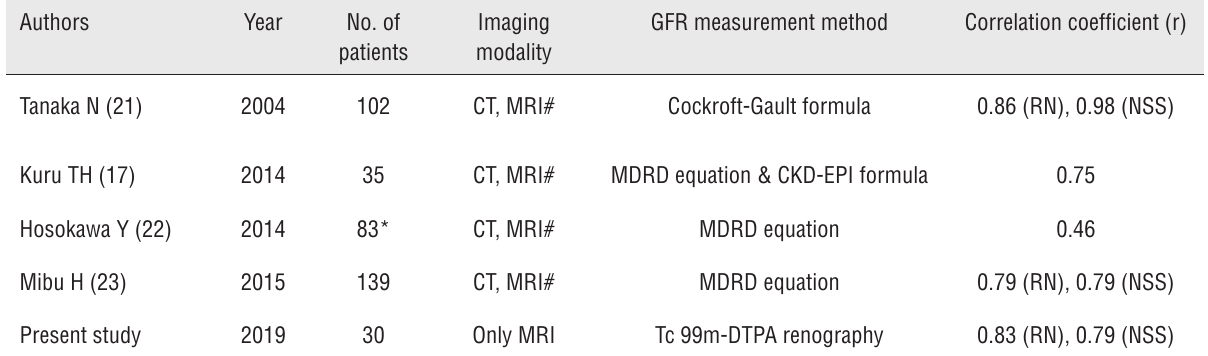
Table 2 - Previous studies correlating MRI based renal volumetry with renal